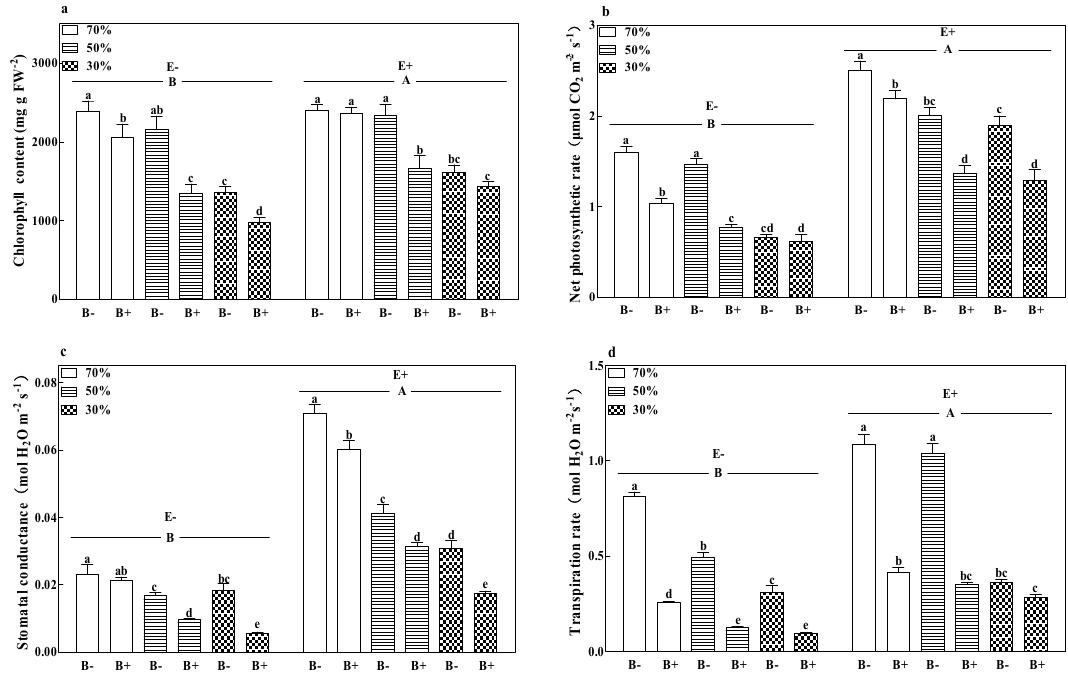
Figure 2. Chlorophyll content ( a ), net photosynthetic rate ( b ), stomatal conductance ( c ), and transpiration rate ( d ) of perennial ryegrass infected with (E + ) or without (E − ) fungal endophyte and inoculated (B + ) or noninoculated (B − ) with pathogen at 70%, 50%, and 30% soil water regimes at harvest. Mean ± SEM of four replicates are shown. Bars topped by the same lowercase letter indicate no significant di ff erence between soil water regimes and pathogen within fungal endophyte treatments at p ≤ 0.05 by Tukey’s HSD test. Bars topped by the same uppercase letter indicate no significant di ff erence associated with fungal endophyte at p ≤ 0.05 by Tukey’s HSD test.